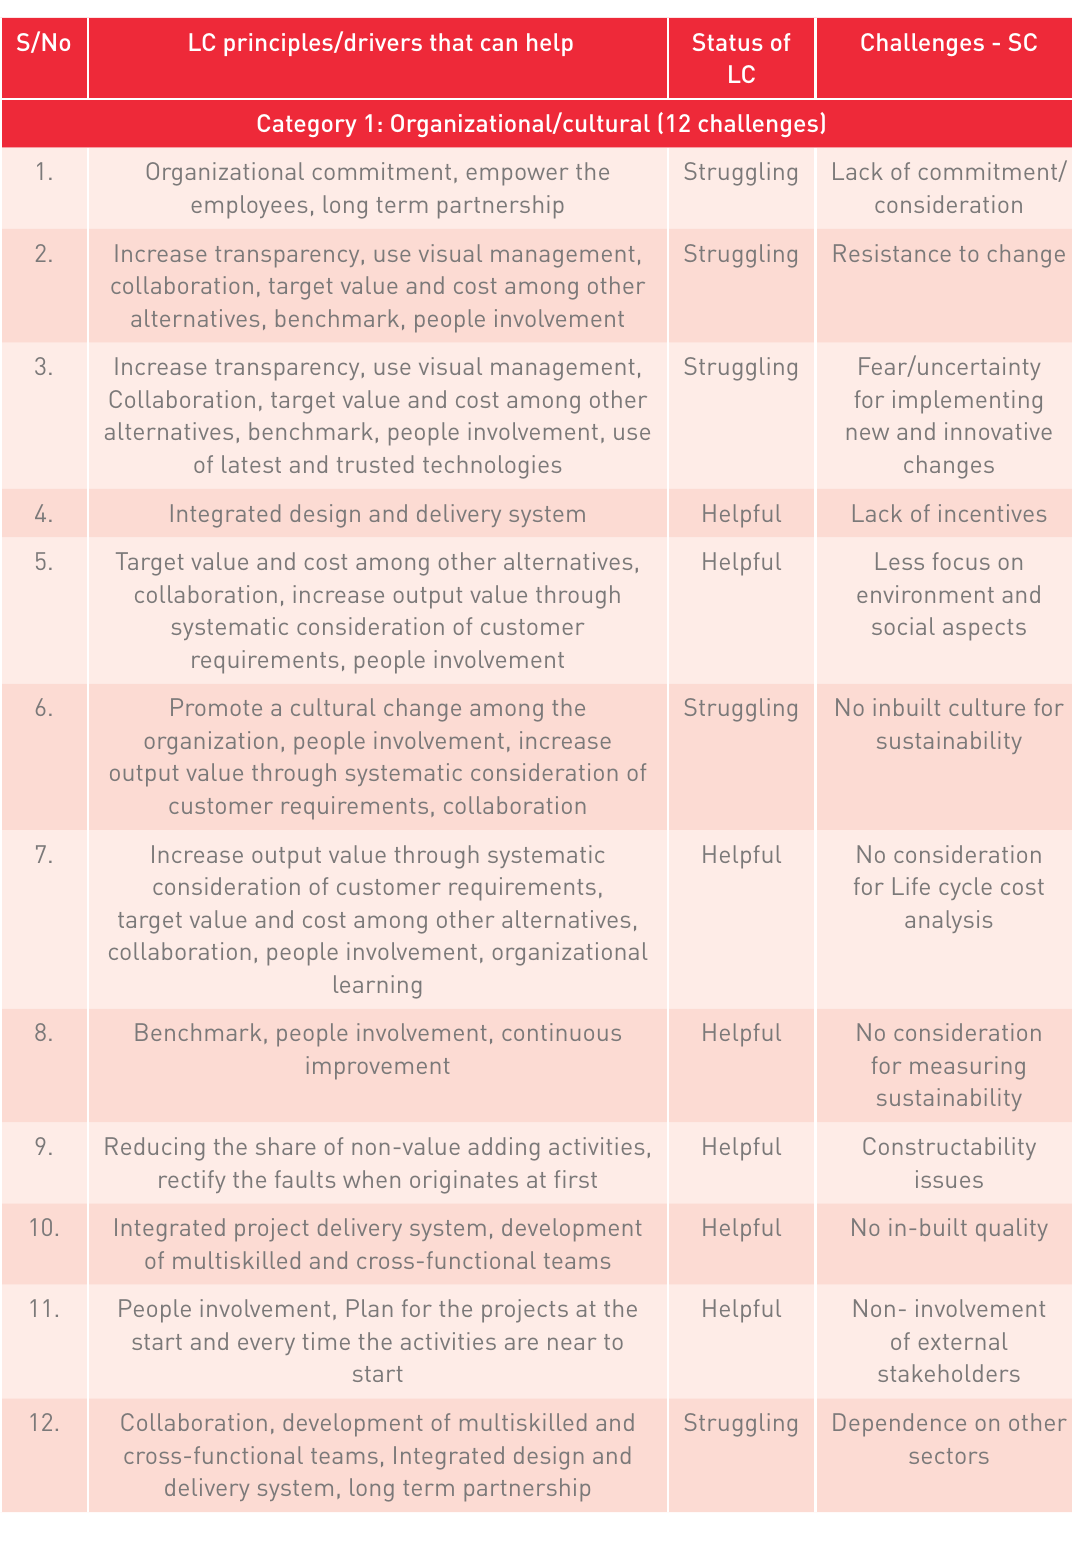
Table 3. Status of LC principles in overcoming the SC challenges